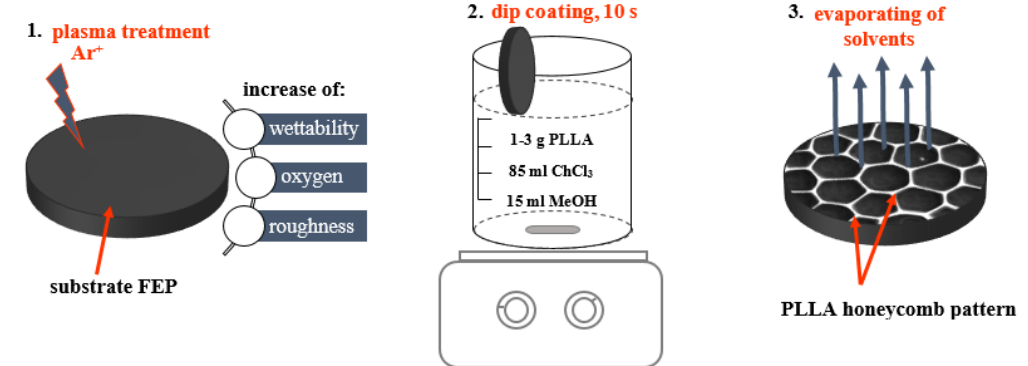
Figure 1. Step-by-step preparation of the poly( L -lactide) (PLLA) film.